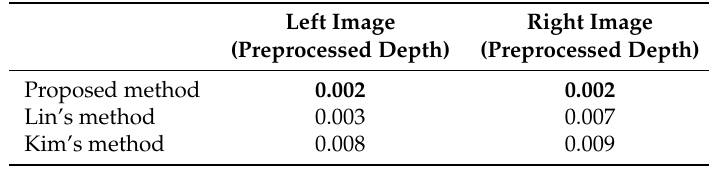
Table 6. Average BER of synthesized images using the preprocessed depth image.